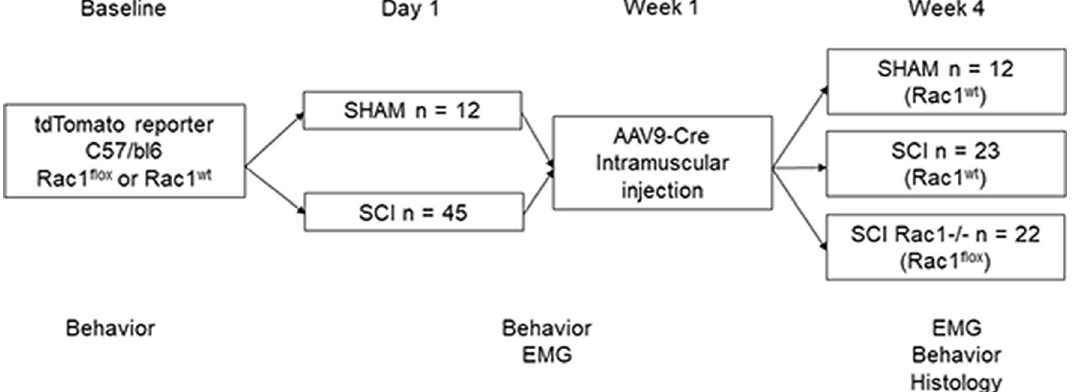
Figure 1. Study design. All animals underwent baseline behavioral testing and were randomly assigned to either SCI or sham groups. Spinal reflex excitability (EMG) and locomotor behavior was tested one-week post SCI or Sham prior to intramuscular injection of AAV9CMVCre into the left hindlimb soleus and gastrocnemius muscles. To assess the effect of conditional Rac1 KO (SCI Rac1−/−), locomotor behavior and spinal reflex testing was conducted after AAV9CMVCre injection at four weeks post-SCI. After completion of EMG and behavioral testing, tissue samples were collected for histology and dendritic spine